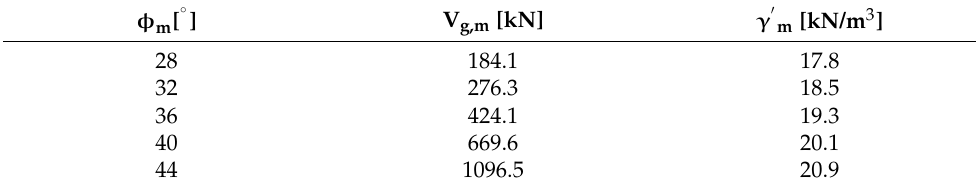
Table 4. The mean values of random variables used in parametric reliability